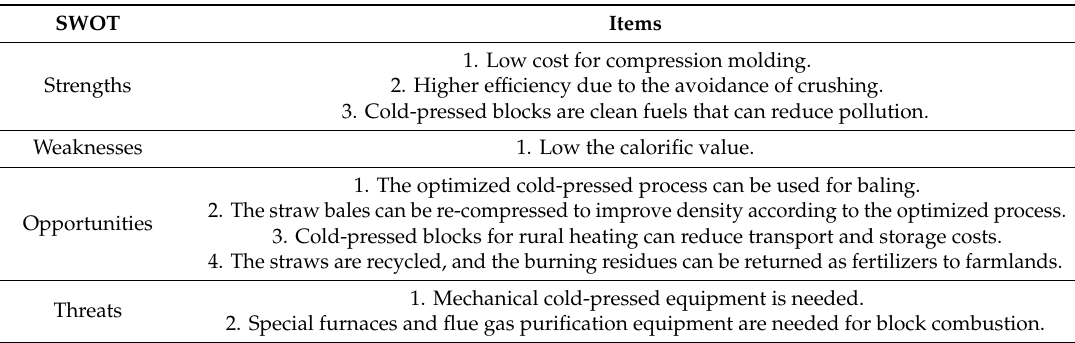
Table 9. The SWOT analysis of cold-pressed chopped corn straws for